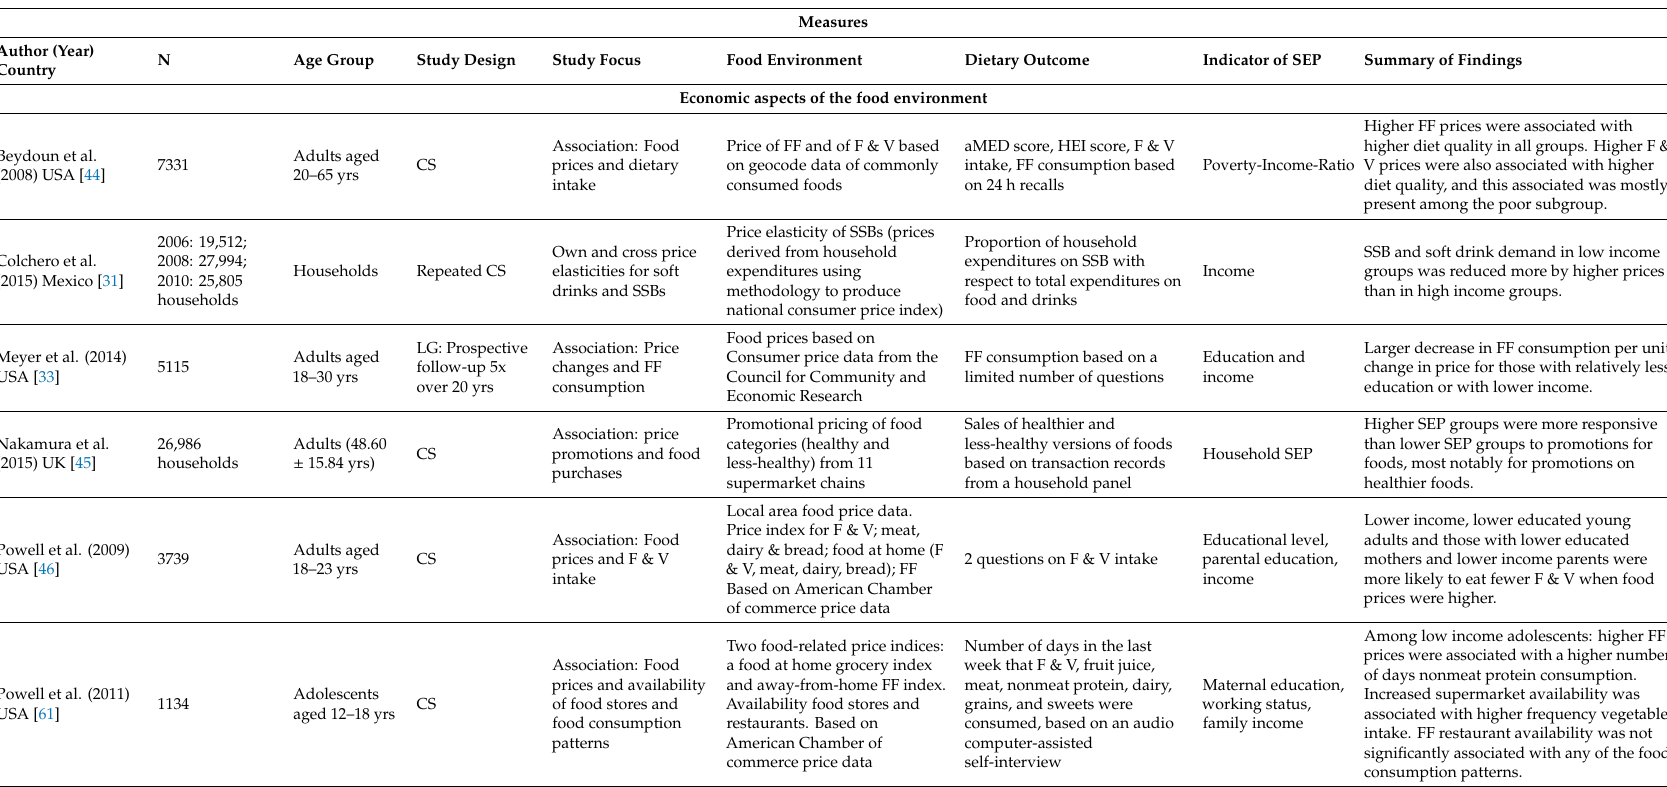
Table 2. Overview of included studies reporting on associations between aspects of the food environment and diet across di ff erent socioeconomic groups—by type of food environmental factor